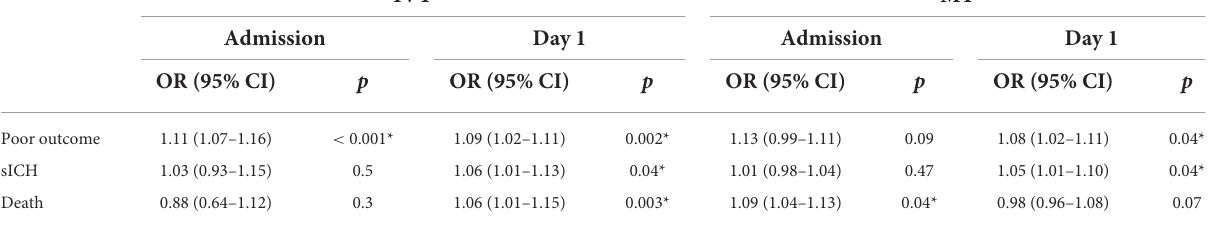
TABLE 7 Adjusted multivariate analysis for neutrophil–lymphocyte ratio (NLR) prediction